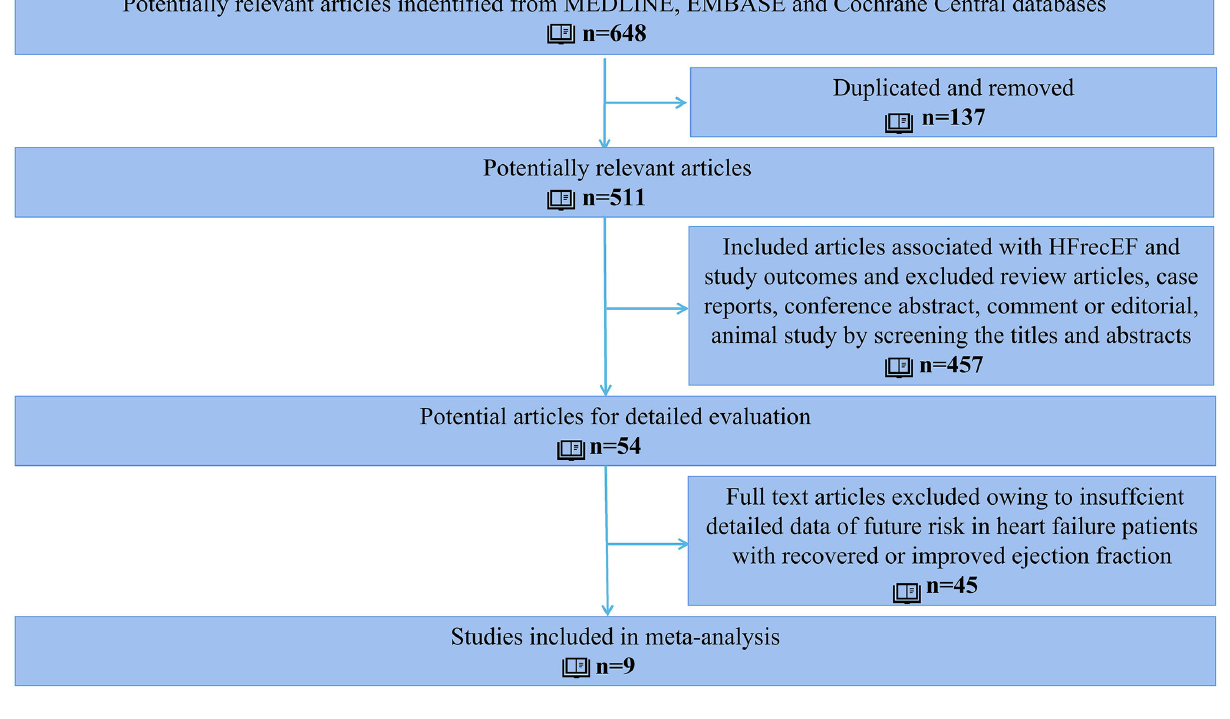
FIGURE 1 | Flowchart of studies selection in the